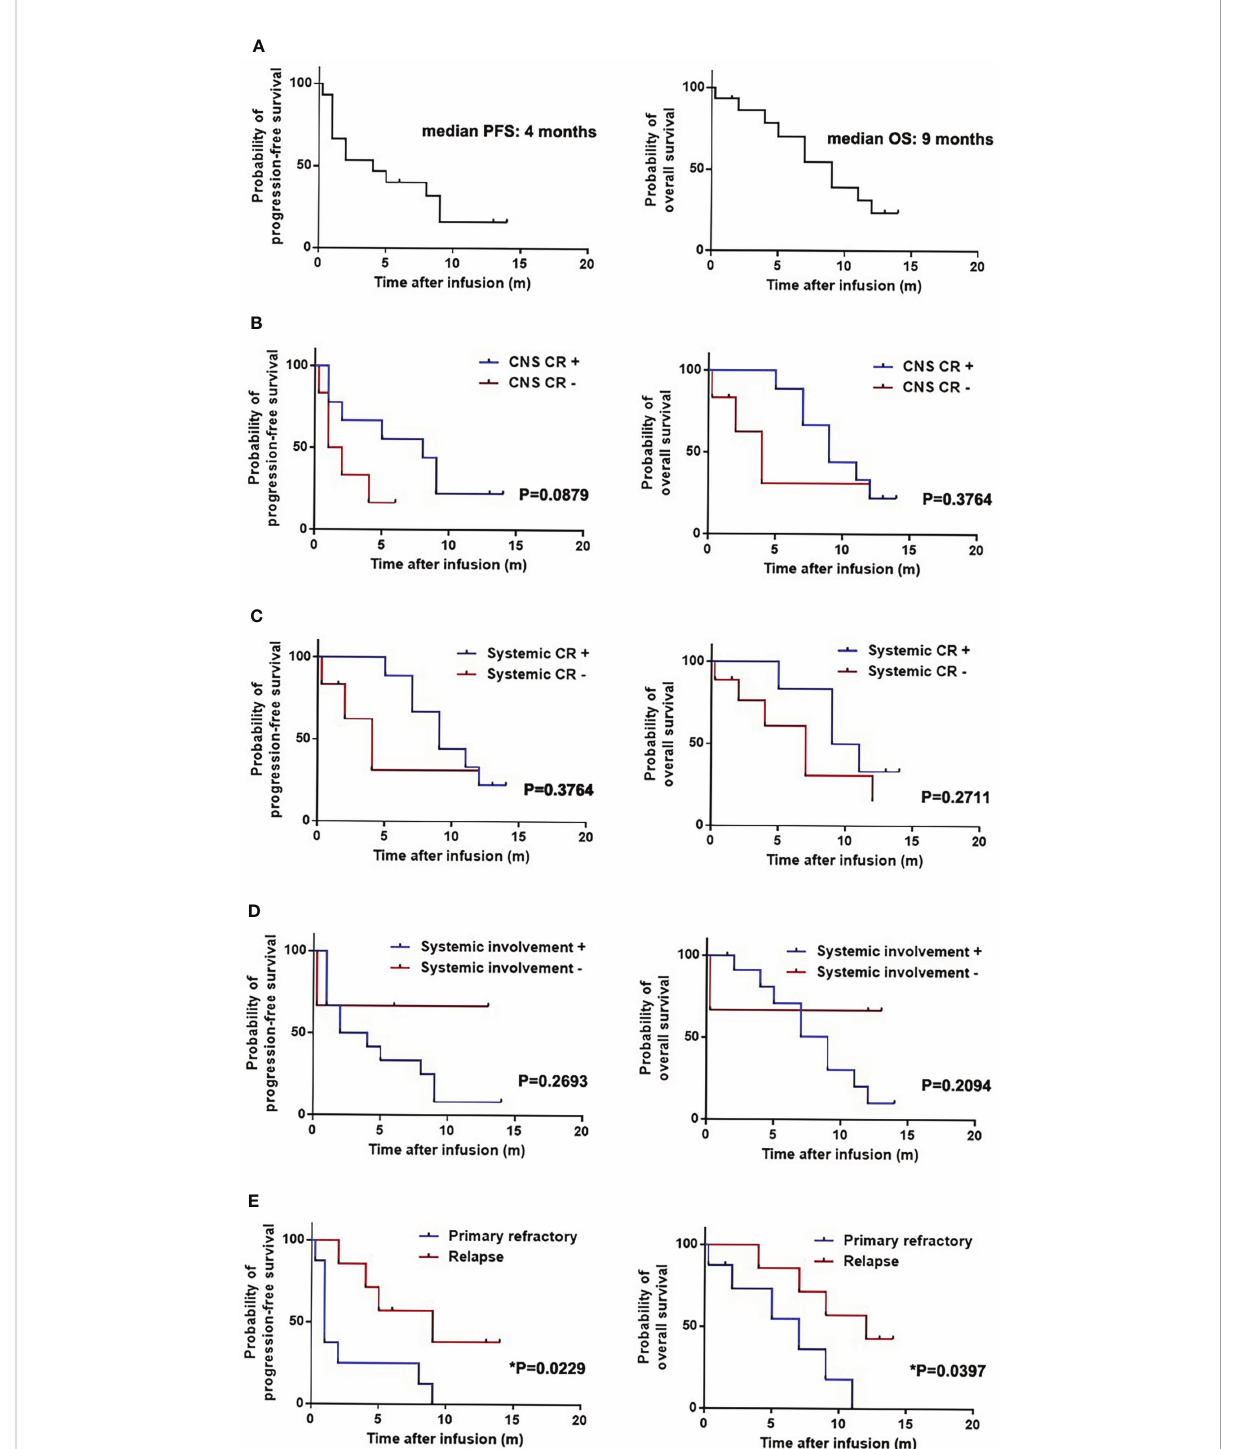
FIGURE 1 Progression-free survival (PFS) and overall survival (OS) of patients with secondary central nervous system lymphoma (CNSL) after CD19-speci fi c CAR-T cell-based therapy. (A) PFS and OS of 15 patients with secondary central nervous system lymphoma (CNSL) after CD19-speci fi c CAR-T cell-based therapy. (B) PFS and OS of secondary CNSL patients with or without central nervous system (CNS) disease complete remission (CR) after CD19-speci fi c CAR-T cell-based therapy. (C) PFS and OS of secondary CNSL patients with or without systemic disease CR after CD19- speci fi c CAR-T cell-based therapy. (D) PFS and OS of secondary CNSL patients with systemic involvement or not after CD19-speci fi c CAR-T cell-based therapy. (E) PFS and OS of secondary CNSL patients having primary refractory lymphoma or relapsed